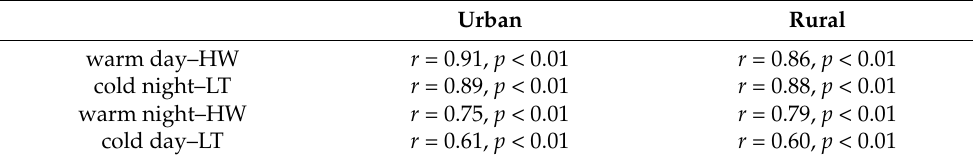
Table 2. Correlation and significance testing between relative extreme indexes and HW (LT). Urban Rural warm day–HW r = 0.91, p < 0.01 r = 0.86, p < 0.01 cold night–LT r = 0.89, p < 0.01 warm